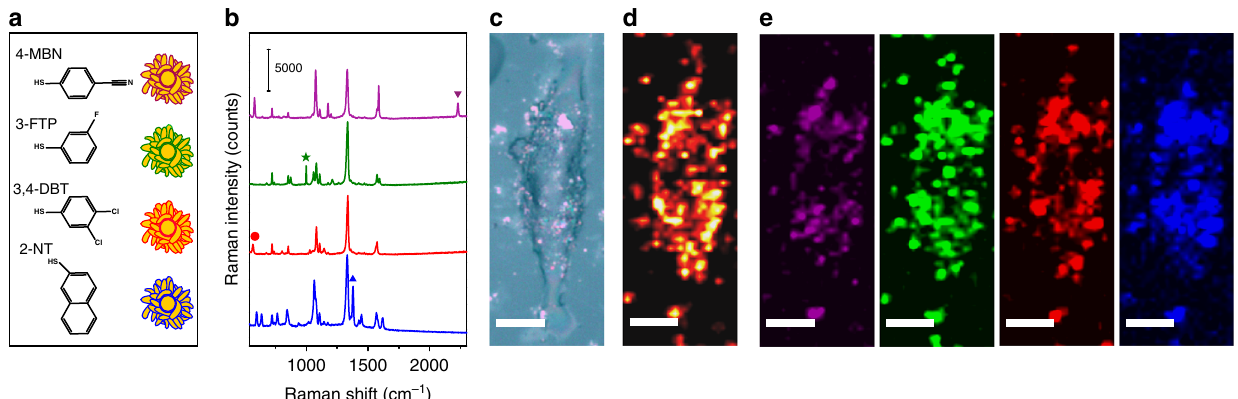
Fig. 6 Multiplexed Raman imaging of a H1299 cell. a Schematics and b SERS spectra of P-GERTs with different Raman reporters of 4-MBN (purple), 3-FTP (green), 3,4-DBT (red), and 2-NT (blue) immobilized in the external nanogaps. c Bright- fi eld image and ( d , e ) multiplexed SERS cell imaging of a single H1299 cell. Raman image in panel d was plotted from 1340 cm − 1 of embedded 4-NBT reporter and images in e were plotted from the Raman signals from external Raman reporters 4-MBN (purple), 3-FTP (green), 3,4-DBT (red), and 2-NT (blue), respectively. All scale bars are 10